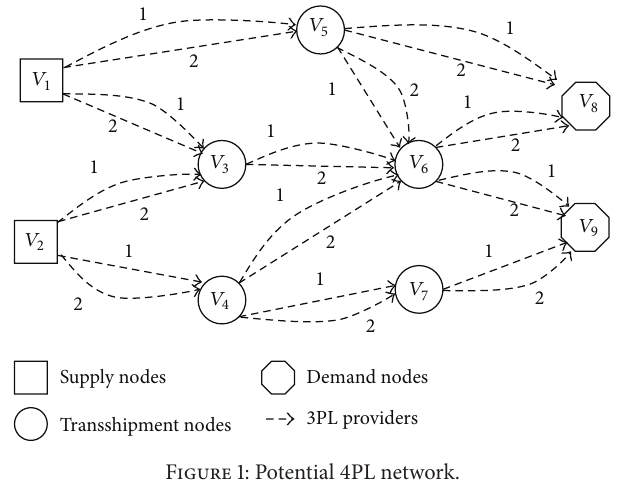
Figure 1: Potential 4PL